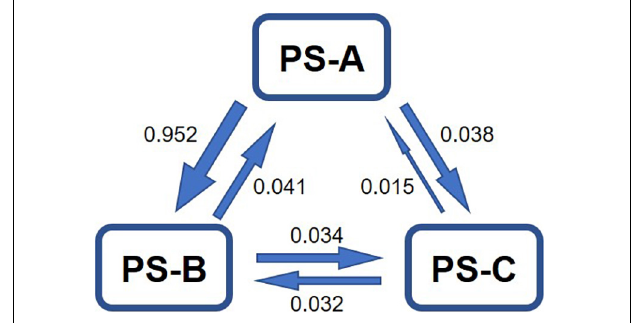
FIGURE 5 | Estimated asymmetric gene flow, based on microsatellite data, among the three lineages of Parantica sita (PS-A, PS-B, and PS-C). Numbers indicate the number of migrants per